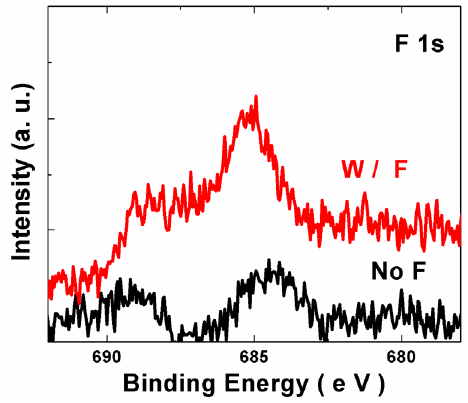
Figure 3. XPS analysis of the F 1 s electronic spectra for the control sample and fluorinated